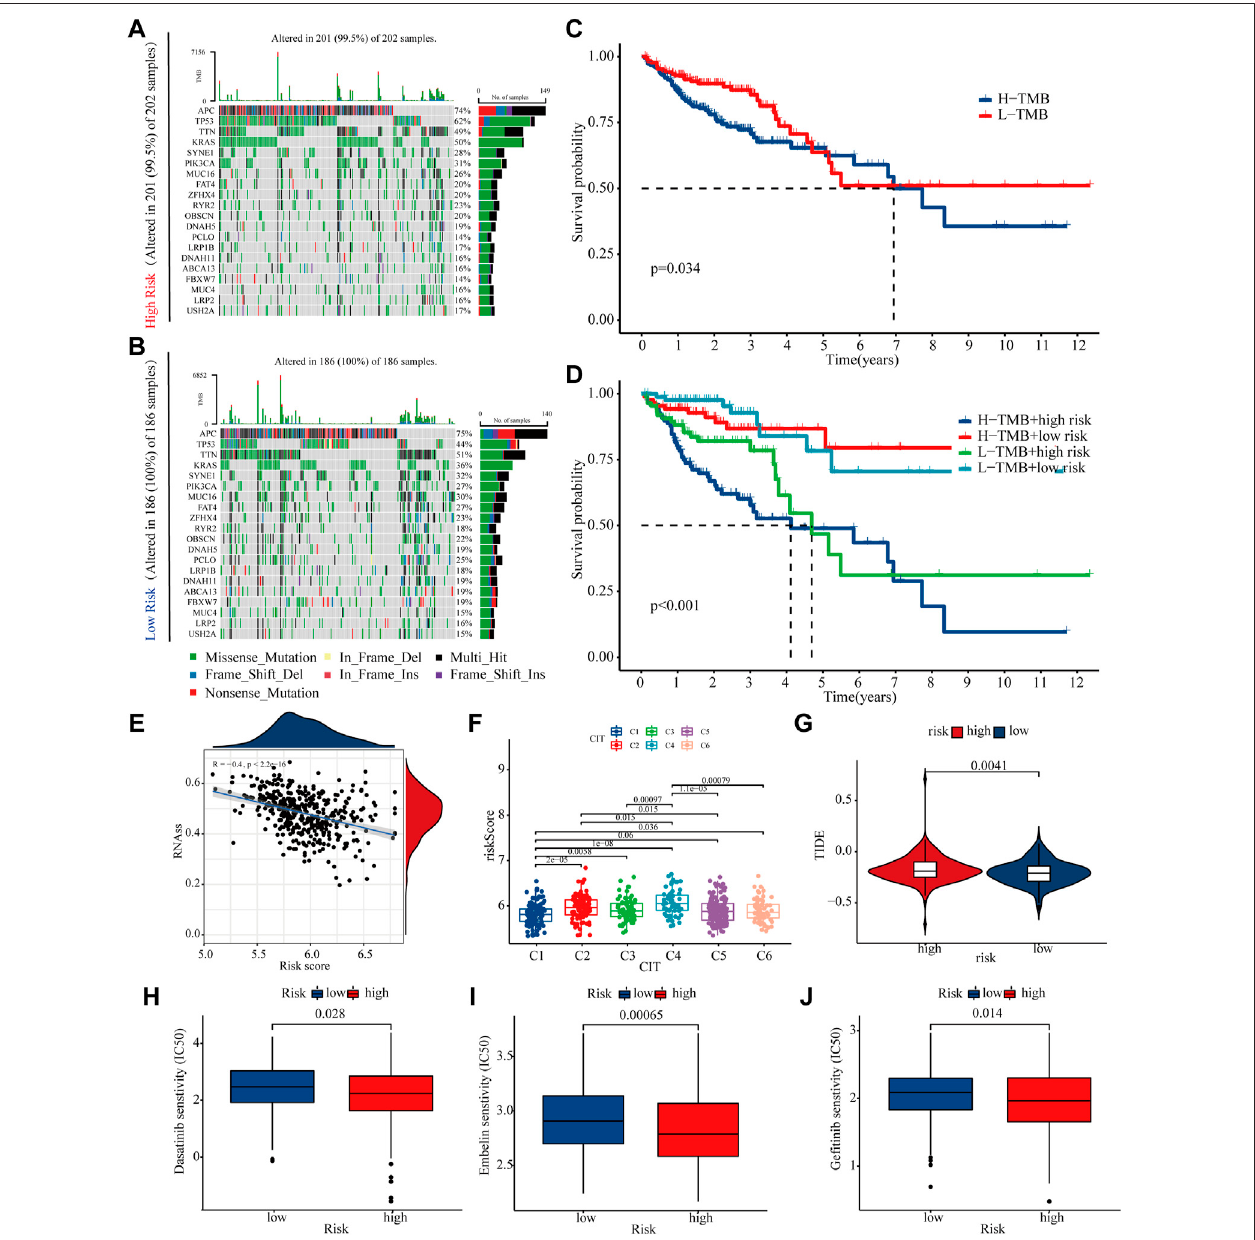
FIGURE 8 | Mutations and treatment sensitivity between high- and low-risk (A,B) The top 20 genes ’ Mutation rate in the high- and low-risk groups (C,D) K-M curves of risk score and tumour mutational load used to assess patient survival (E) The risk score is negatively correlated with the stem cell index (F,G) TIDE and GSE39582 database were used to validate patient sensitivity to immunotherapy between the high- and low-risk groups (H – J) The association between risk score and drug treatment sensitivity.